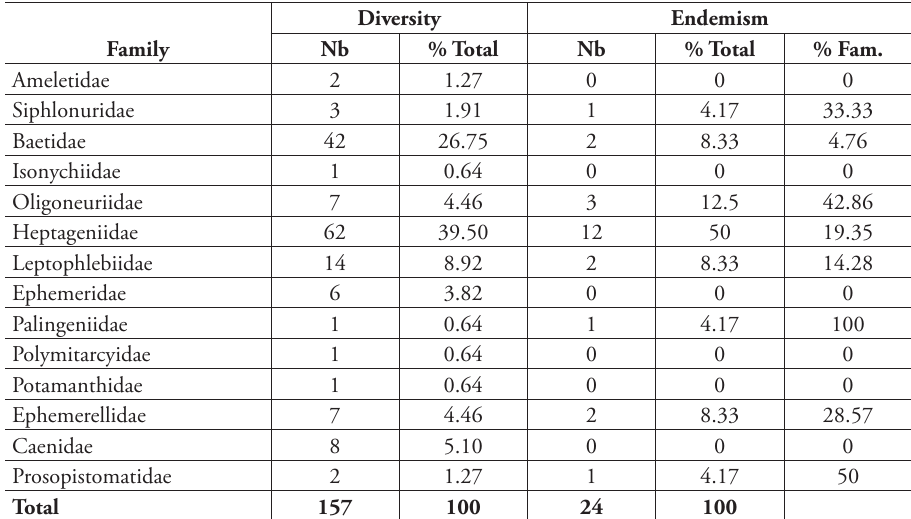
Table 1. Diversity among the different families occurring in Turkey (Nb = number, % Total = % of total species number, % Fam. = % only within the family). Family